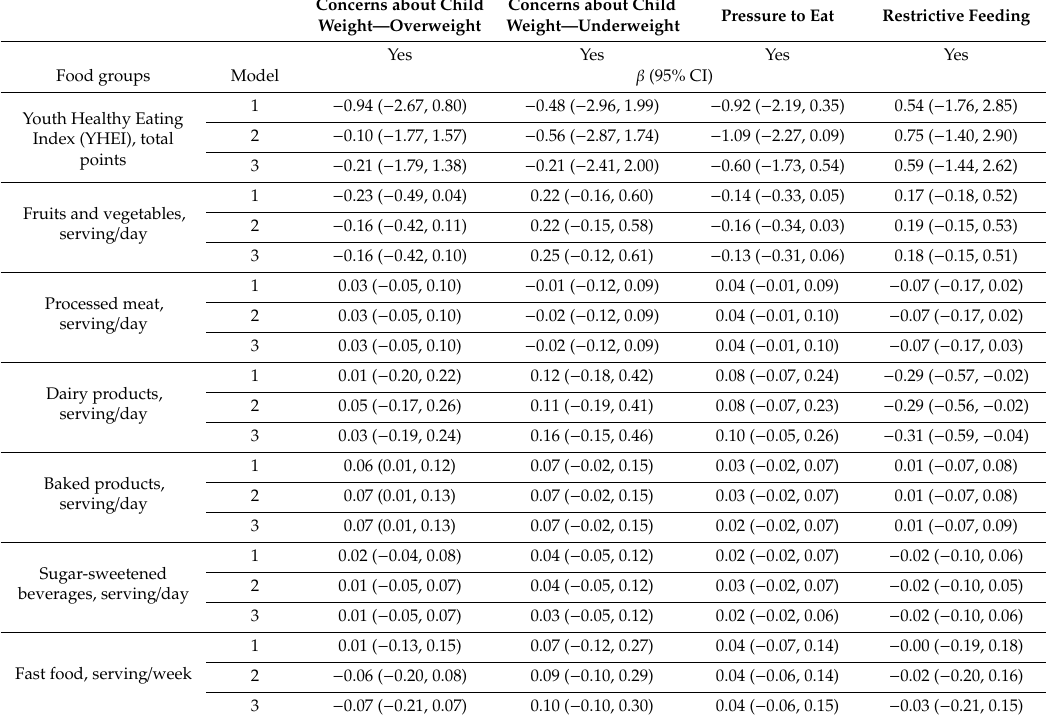
a Model 1: adjusted for child’s sex and age at outcome assessment, maternal education, marital status and age at inclusion, household income, and child’s race / ethnicity; Model 2: Model 1 additionally adjusted for maternal pre-pregnancy body mass index, paternal body mass index, and maternal diet quality during pregnancy; Model 3: Model 2 additionally adjusted for child body mass index z-score from and YHEI at 2